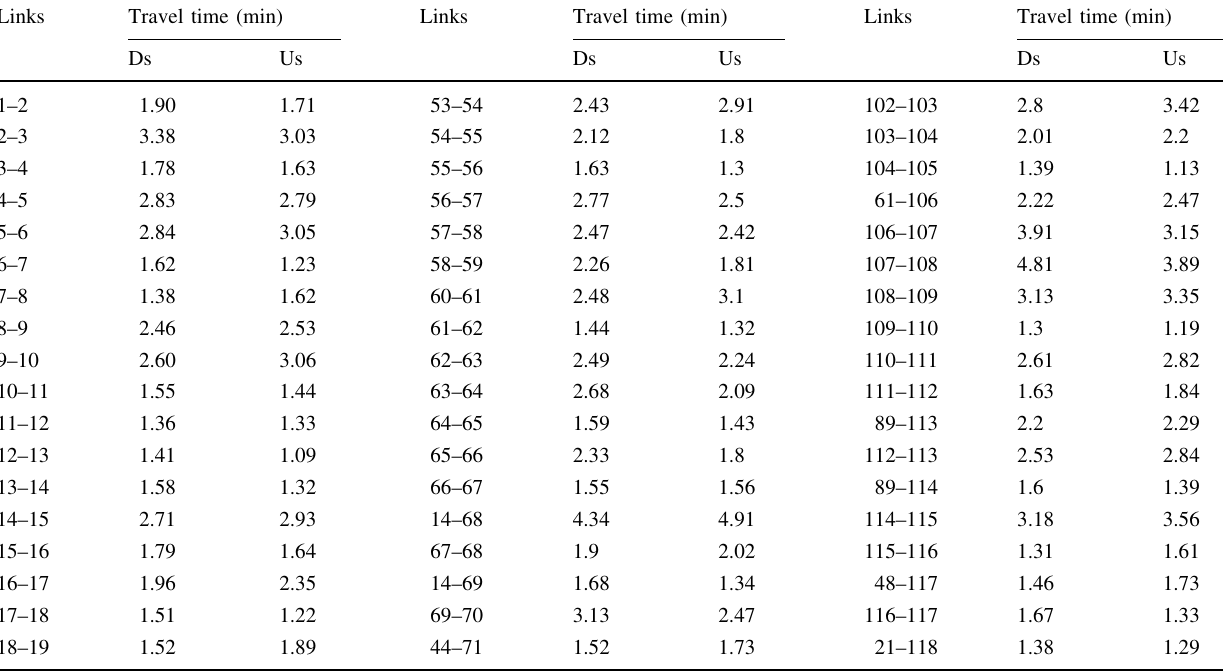
Table 5 Travel time for all links in Wuhan’s subway network during peak hours